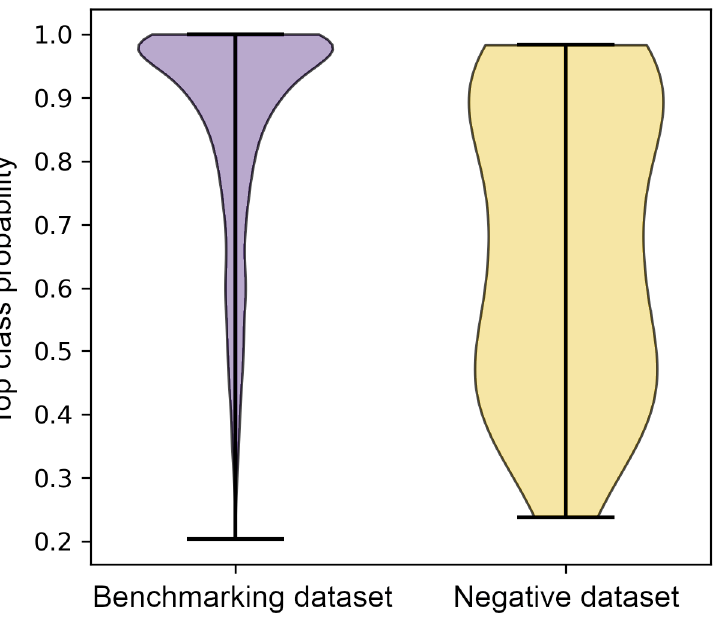
Figure 5. Distribution of the classification confidence for benchmarking and negative datasets. The classification confidence corresponds to a probability of the top-ranked ligand binding class predicted by GraphSite.